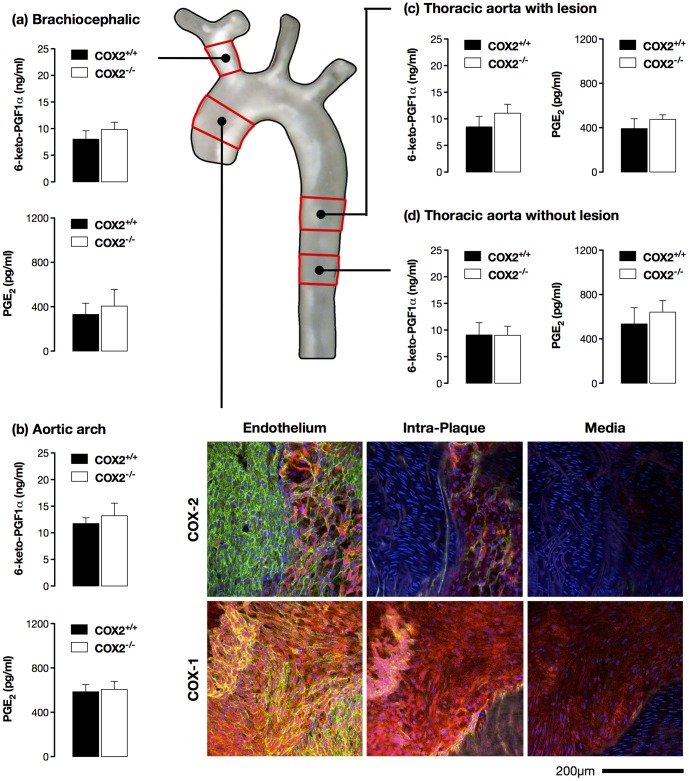
COX-2 deletion does not alter prostacyclin production by atherosclerotic vessels.Production of Prostacyclin and PGE2 by isolated rings of brachiocephalic artery (a) and aortic arch (b), and from plaque-bearing (c) and plaque-free regions of thoracic aorta (d) from fat-fed apoE−/−/COX-2+/+ and apoE−/−/COX-2−/− mice demonstrated little role for COX-2 in the production of either prostaglandin in atherosclerotic vessels. In agreement, en face confocal immunofluorescence imaging of the lesser curvature of the aortic arch (b) suggests that whilst both COX-1 and COX-2-like immunoreactivity was present in atherosclerotic vessels, the COX-1 isoform was the predominant isoform. Sequential (Z) scanning through en face vessel preparations suggested COX-2 was more abundant in the endothelial and intraplaque layers than the media. Images are merges of red (COX1 or COX2), green (CD31 – endothelial cells) and blue (DAPI – cell nuclei) channels. n = 4–6.